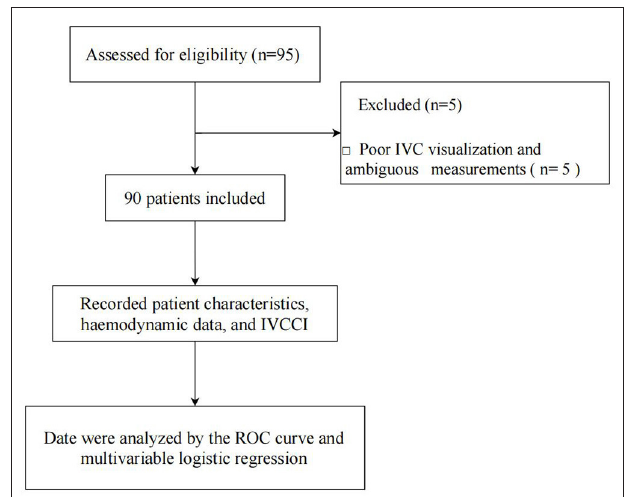
FIGURE 1 | Flow diagram outlining the study